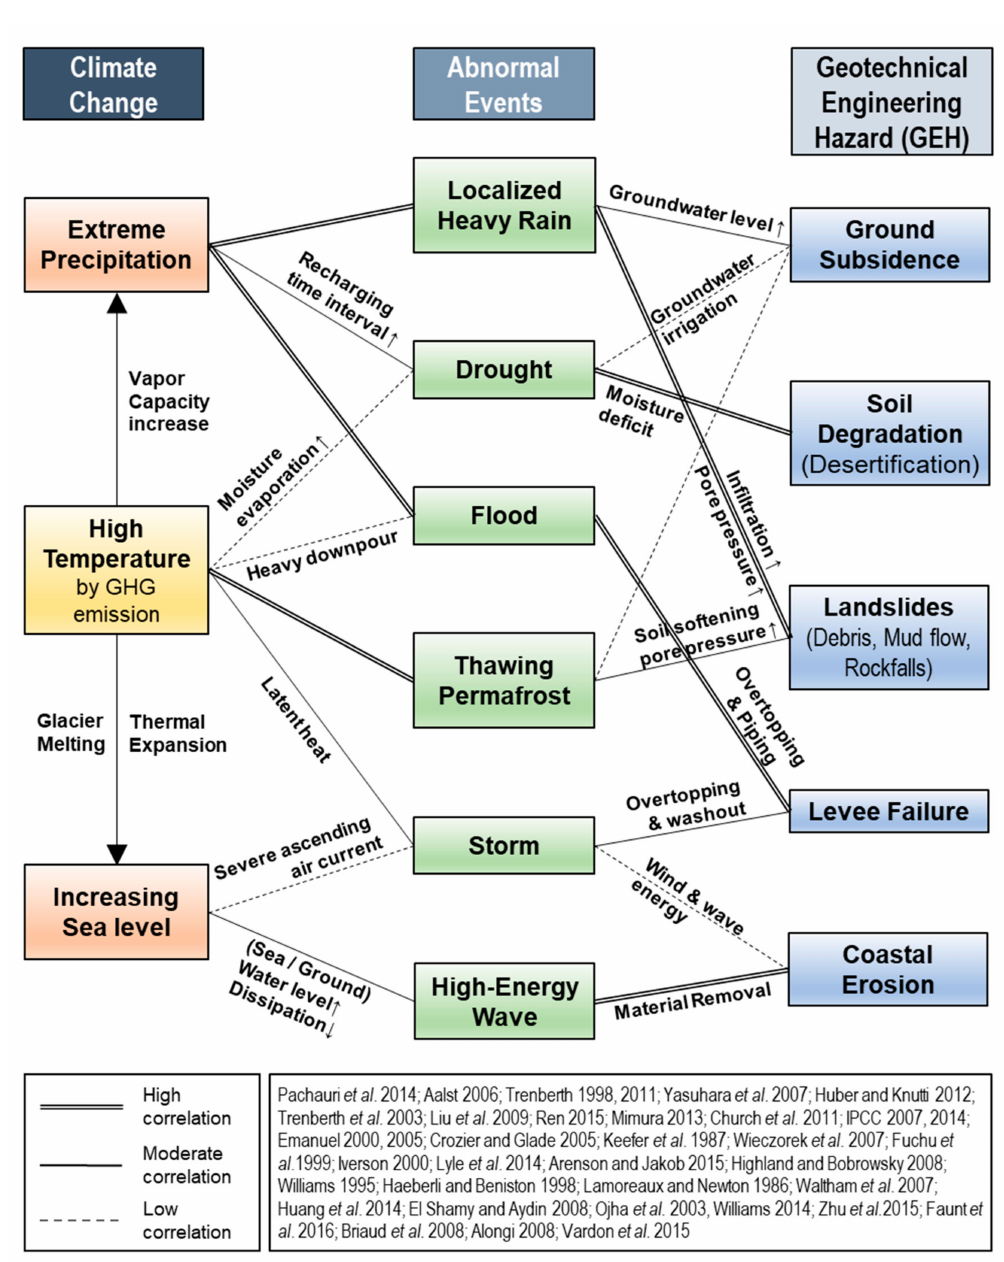
Figure 4. Geotechnical engineering hazard (GEH) events triggered by climate change